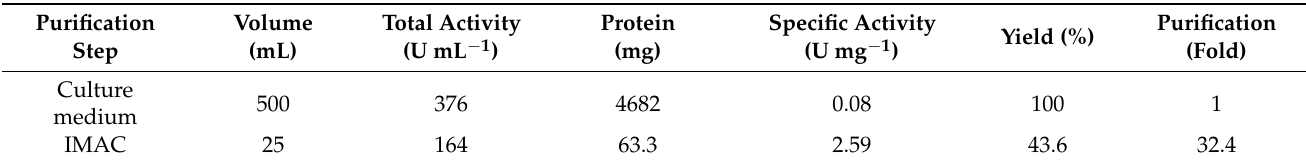
Table 3. Purification for the recombinant DyP1 produced in Pichia pastoris X33 . IMAC: immobilized metal affinity chromatography.